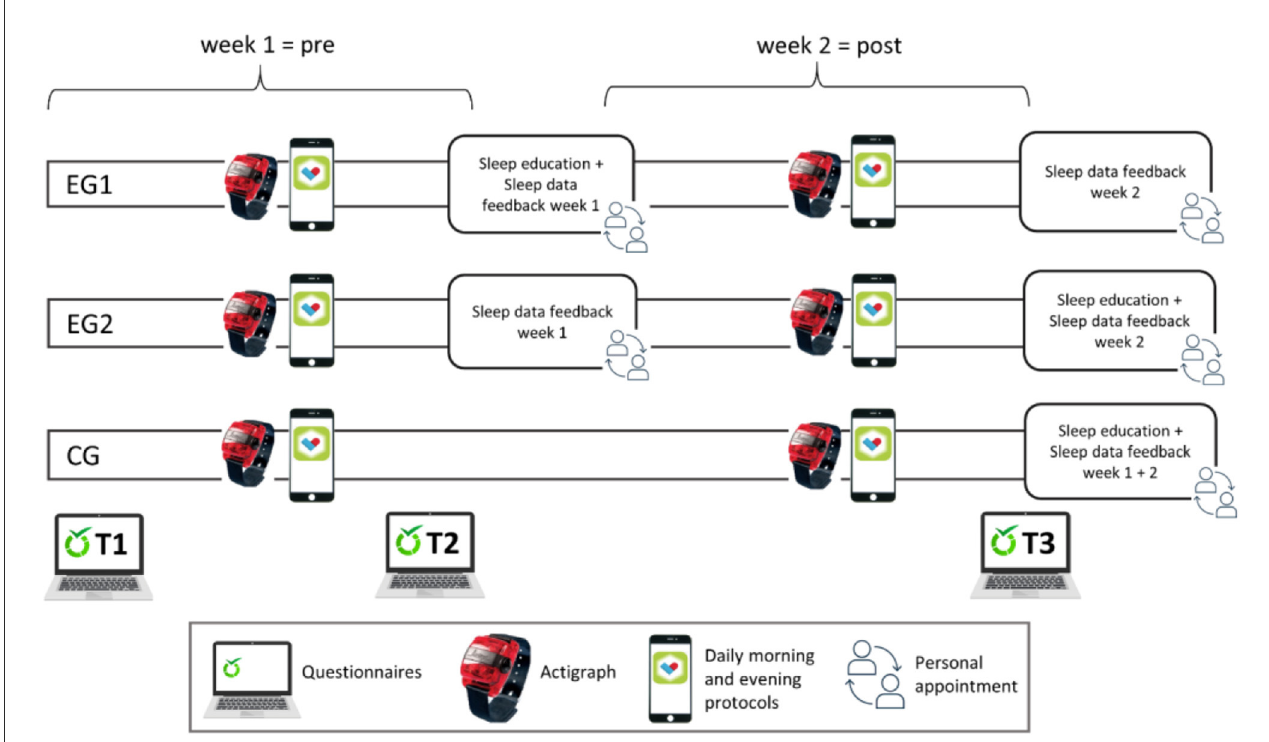
FIGURE1 Study design. Participants wore an actigraph for 2 weeks and filled out questionnaires at three points of time as well as two daily protocols (morning and evening) via a mobile phone app (PsyDiary). During a personal appointment (after week 1), experimental group 1 (EG1) received feedback on their sleep data from the first week plus a sleep education intervention, while EG2 received sleep data feedback only. The waiting-list control group (CG) was monitored like the other groups, but only had a personal appointment and got feedback after the end of the 2-week study